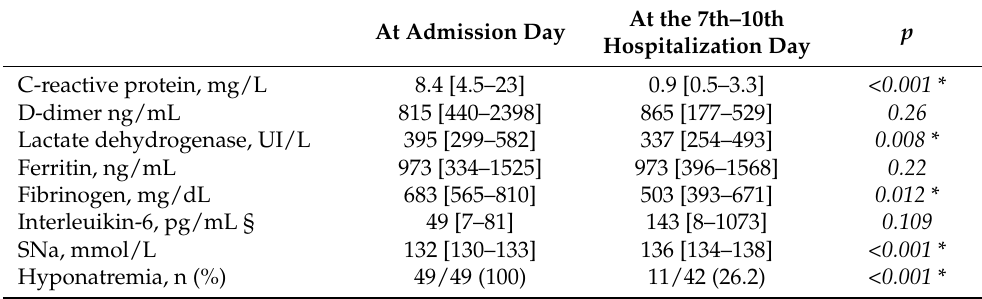
Table 3. Evolution of the inflammatory markers and serum sodium in the global cohort of patients from admission to the 7th–10th hospitalization